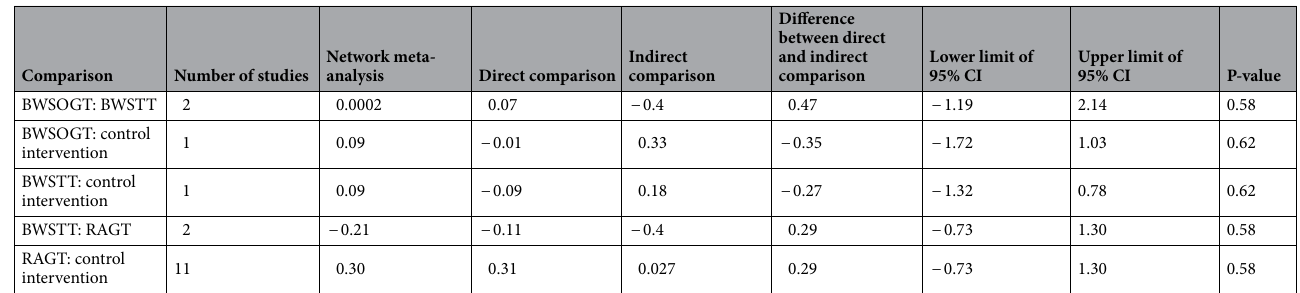
Table 3. Assessment of inconsistency among the included studies. CI, credible interval; RAGT, robot- assisted gait training; BWSTT, body weight-supported treadmill training; BWSOGT, body weight-supported overground